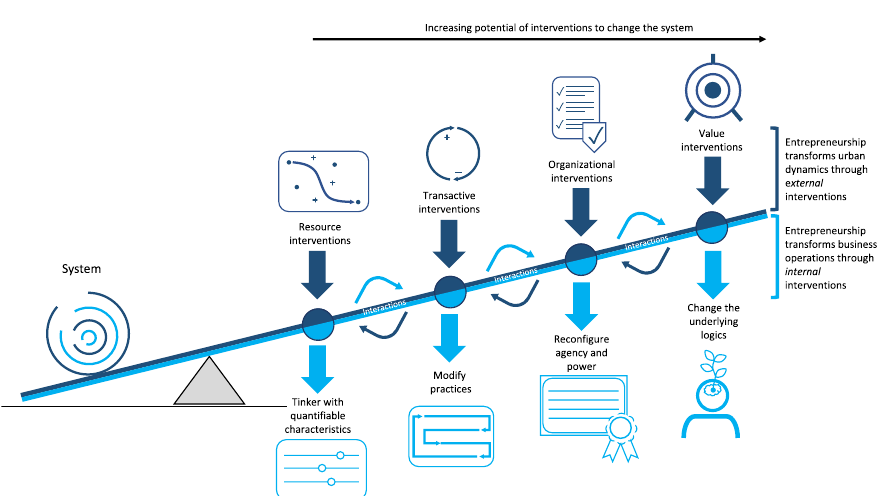
Fig.1 A visualization of how entrepreneurship shapes urban sustainability transformations. The framework depicts two levels at which sustainable entrepreneurship intervenes: the business level (light blue) and the city level (dark blue). Across these two levels, we identified four interventions ( resource, transactive, organizational, and value interventions ) through which sustainable entrepreneurs change business operations and urban dynamics. The higher an intervention is positioned on the seesaw, the greater its potential to initiate ripple effects throughout a given system aside from changing the properties that are targeted. The framework offers a heuristic tool for researchers exploring the bidirectional interactions between firms and the urban context in which they operate to both rigorously examine and explicitly support change for urban